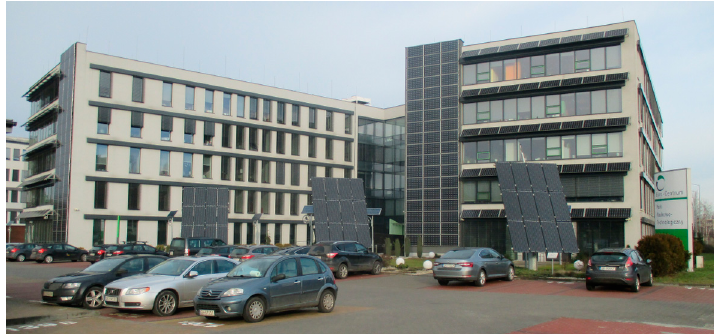
Figure 1. View of the considered building.